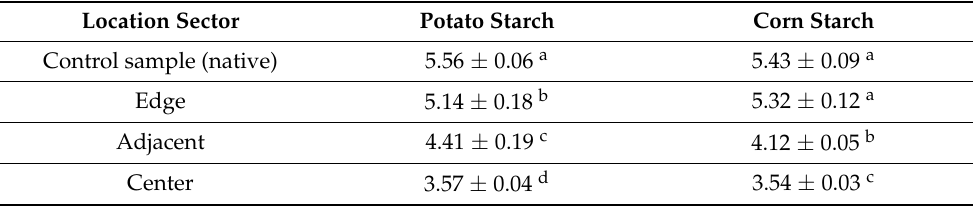
Table 3. pH values for investigated starch